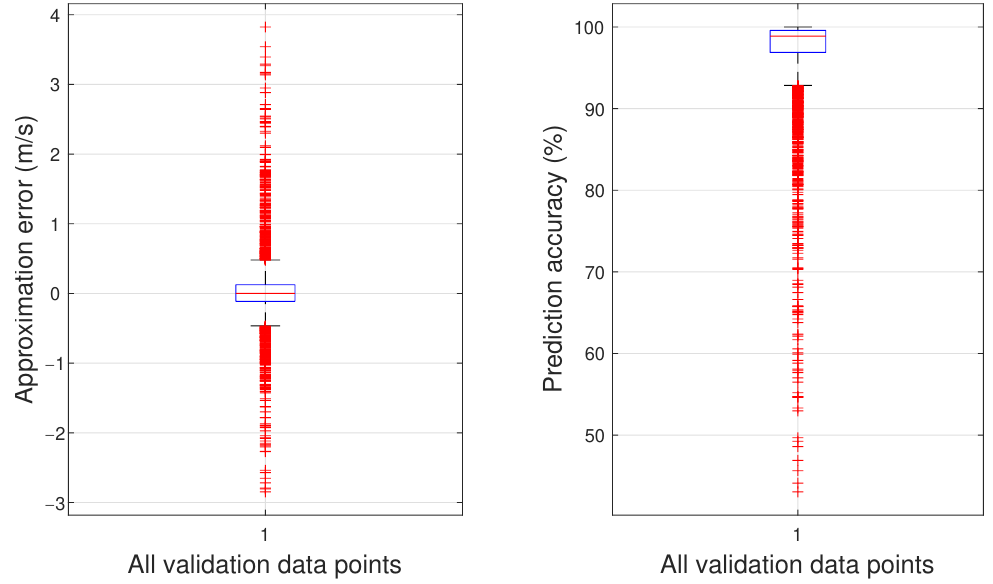
Figure 13. The best model’s approximation errors ( left plot) and prediction accuracy ( right plot) over the validation dataset for an uncertainty of up to 15% applied to the AoA model